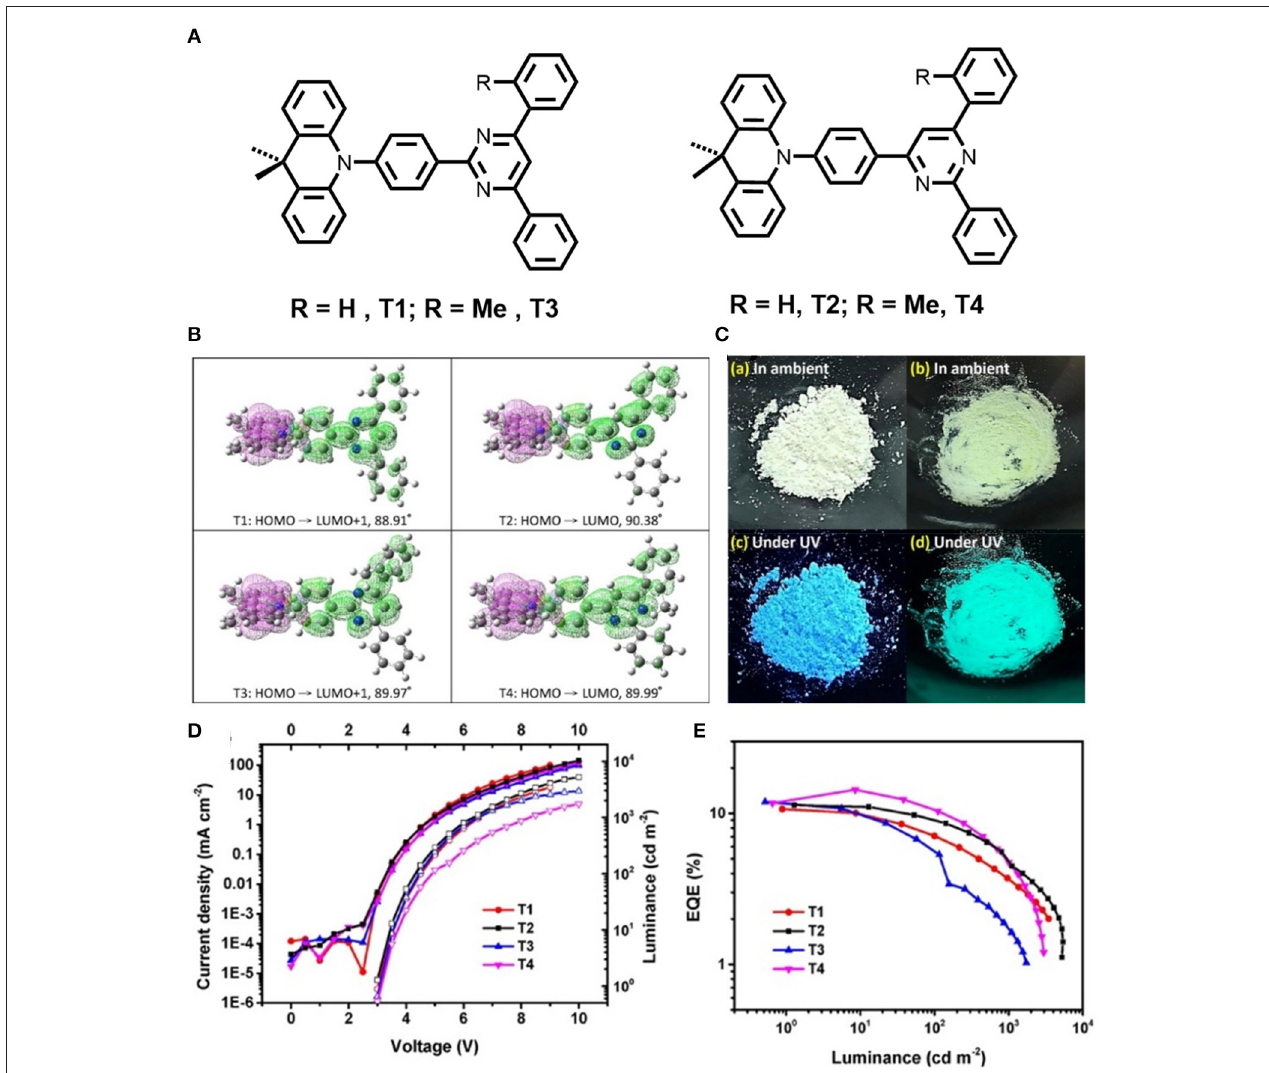
FIGURE 3 | (A) Chemical structures of pyrimidine-acceptor core based TADF molecules. (B) Frontier molecular orbitals (HOMOs and LUMOs) related to the minimum optical transitions with calculated dihedral angles between the planar dimethyl acridine to the central phenylene substituent are 88.91 ◦ and 90.38 ◦ 89.97 ◦ , and 89.99 ◦ for T1-T4 in DCM, respectively. (C) Photographs of the ambient and luminescence materials under UV-lamp; color changes of T2 in response to mechanical grinding. (D) Current density (J) -voltage (V)-luminance, and (E) EQE-luminance plots of the white OLEDs. Reproduced with permission from Ganesan et al. (2017). Copyright © WILEY-VCH Verlag GmbH andamp; Co. KGaA,